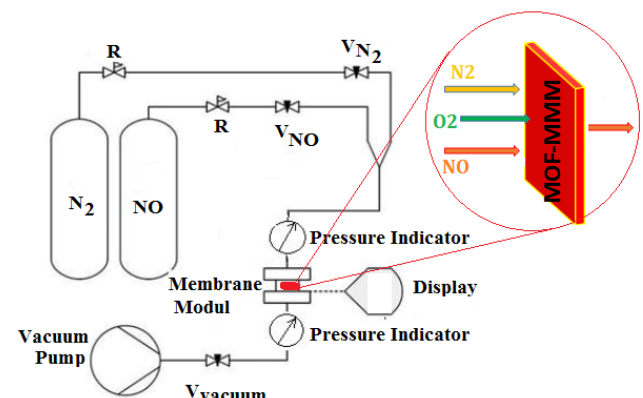
Fig.2. Experimental setup for gas permeation